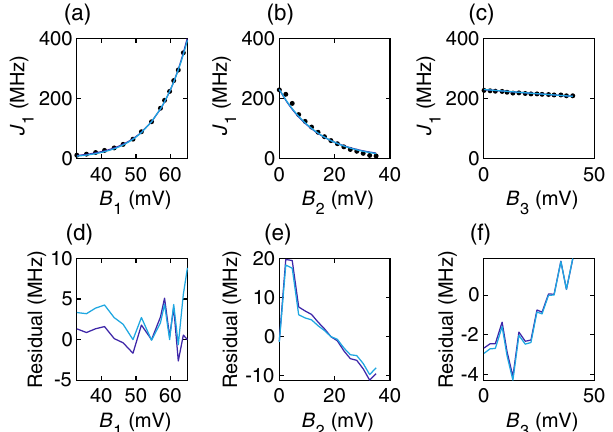
FIG. 3. J 1 vs B j . (a) J 1 vs B 1 . (b) J 1 vs B 2 , for B 1 ¼ 60 mV. (c) J 1 vs B 3 , for B 1 ¼ 60 mV. The black data points in each panel are obtained from the fast Fourier transform of a dataset similar to Fig. 1(b) in the main text. In (a) – (c), the dark blue line is the fit to the exponential model, and the light blue line is the fit to the HL model. The dark and light blue lines are nearly overlapping. Panels (d) – (f) show the difference between the fits and the data for the two